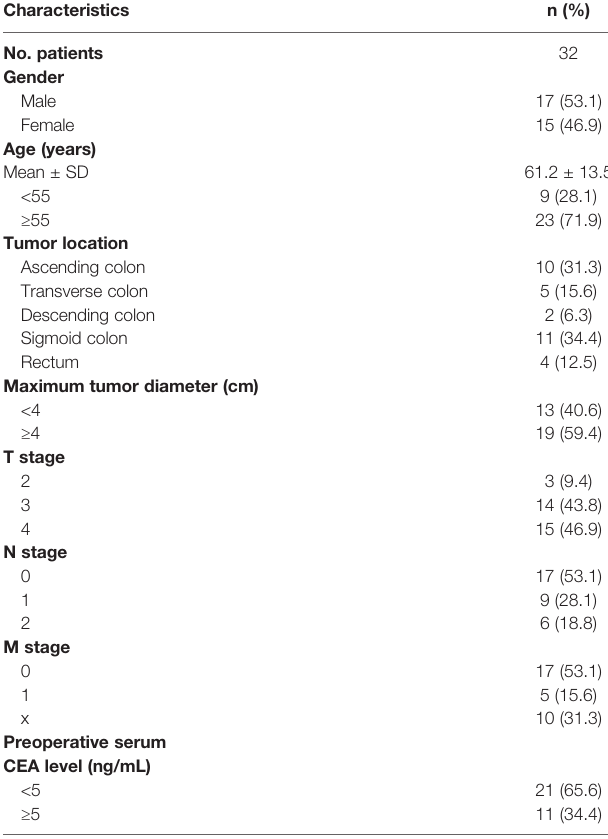
TABLE 1 | Demographics and clinicopathologic characteristics of